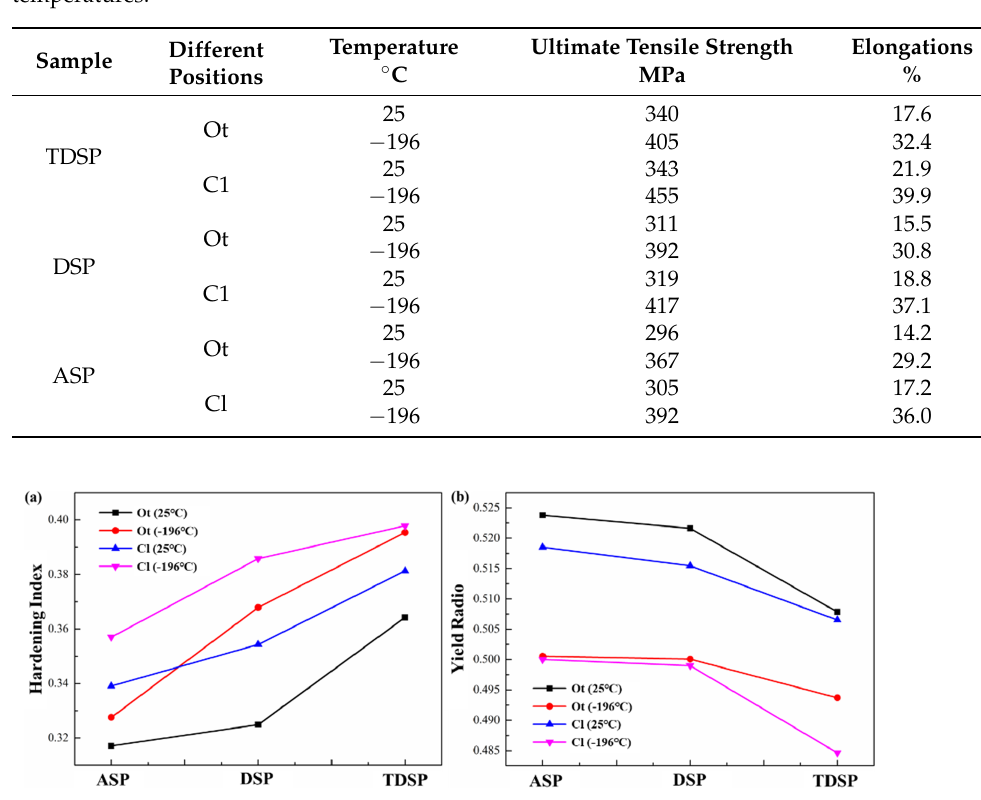
Figure 5. The n values and yield-strength ratios of the Ot and Cl samples of three different plates at different temperatures: ( a ) 25 °C; ( b ) − 196 °C.